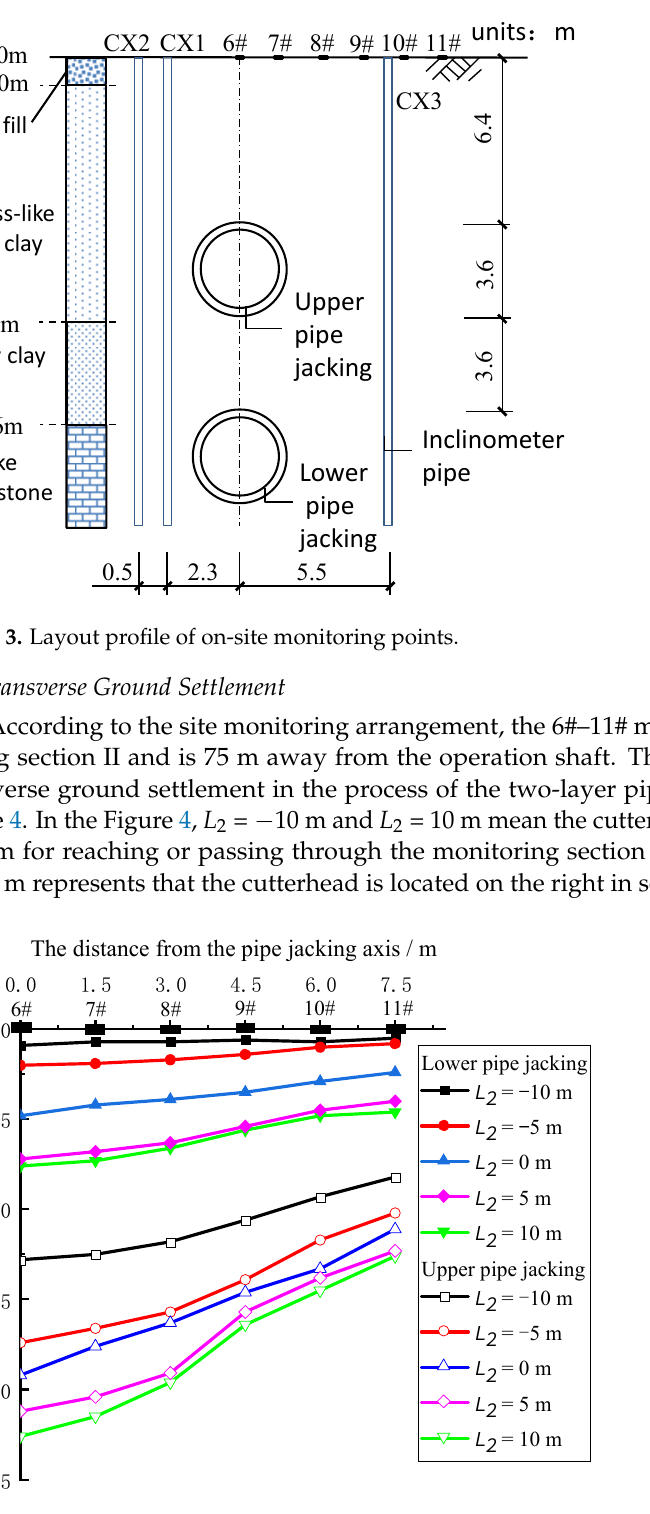
Figure 4. Transverse ground settlement.